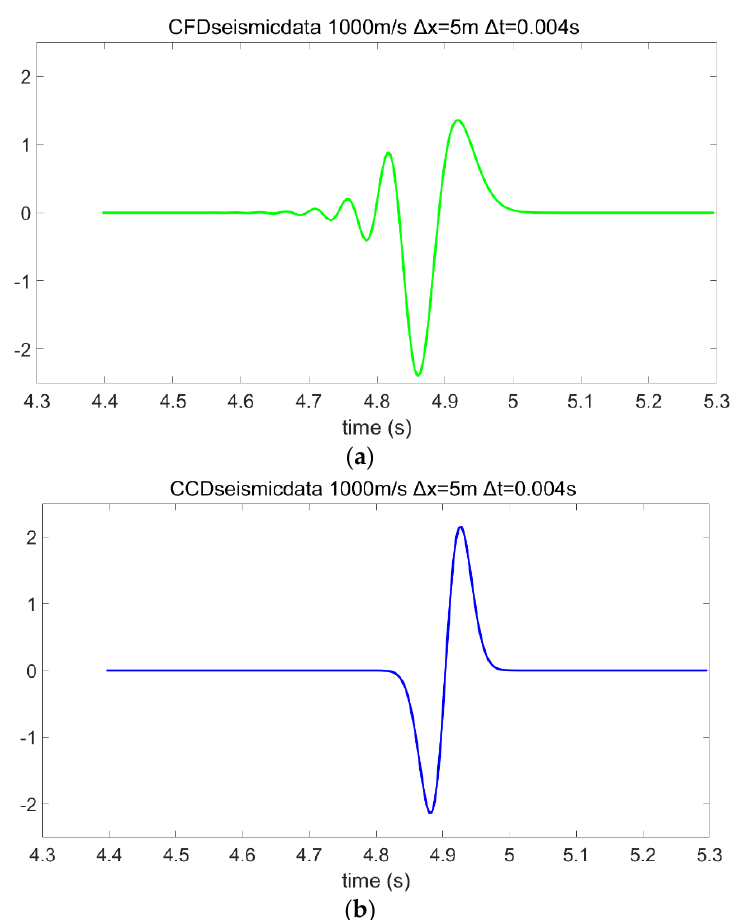
Figure 6. ( a ) CFD is used to simulate the numerical simulation of seismic records in the 1D homogeneous medium model, Δ t = 0.004 s; ( b ) CCD is used to simulate the numerical simulation of seismic records in the 1D homogeneous medium model, Δ t = 0.004 s.